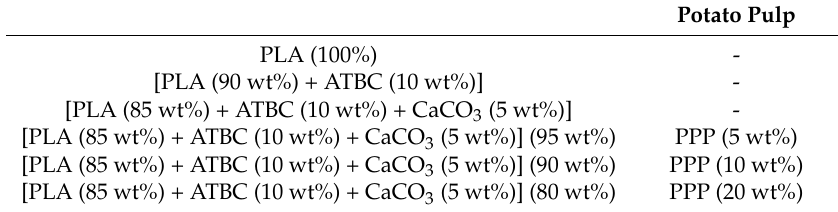
Table 1. Composition of the poly(lactic acid) (PLA)-based matrix and